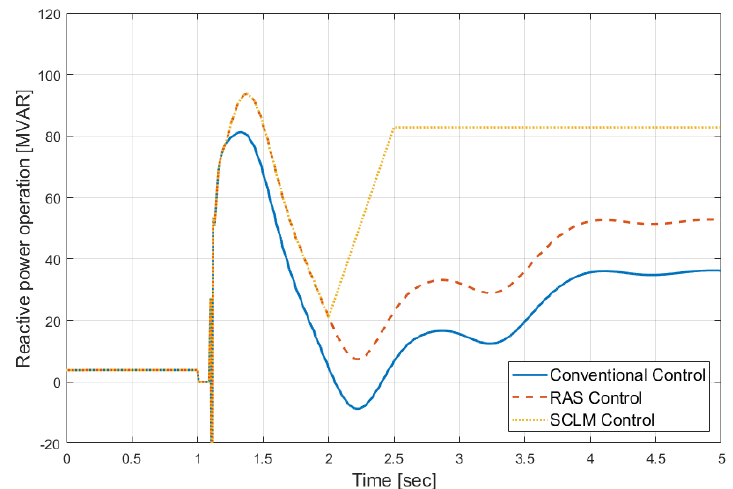
Figure 9. Reactive power operation change in the transformer overload case at the rectifier end.